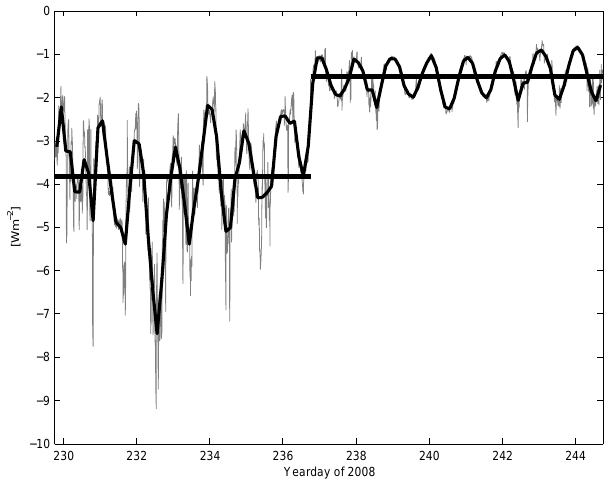
Fig. 7. Turbulence mast measurements at 3.8m depth (2m below ice/ocean interface) averaged in 3-h intervals. Time series of (a) current speed relative to the ice, (b) friction velocity, u ∗ , ± one standard deviation (circles and errorbars) and temperature elevation above freezing, 1T , (grey shading) and (c) ocean heat flux where grey shading indicates ± one standard deviation. Red squares in (b) and (c) are friction velocities and heat fluxes from the TIC at 7.8m depth, calculated as described in the text.